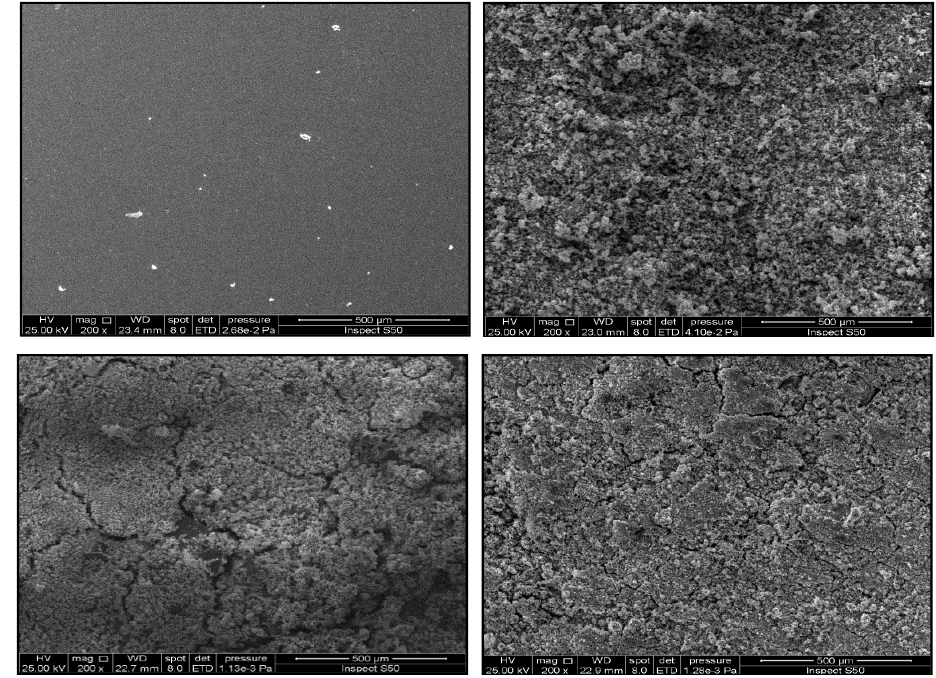
Fig. 5. SEM micrographs of carbon steel surface (a) before immersion in 0.5M H 3 PO 4 , (b) after corrosion in 0.5M H 3 PO 4 , (c) after inhibition 0.5M H 3 PO 4 + 175 ppm of drug at 30 o C, and (d) after inhibition 0.5M H 3 PO 4 + 225 ppm of drug at 60 o C